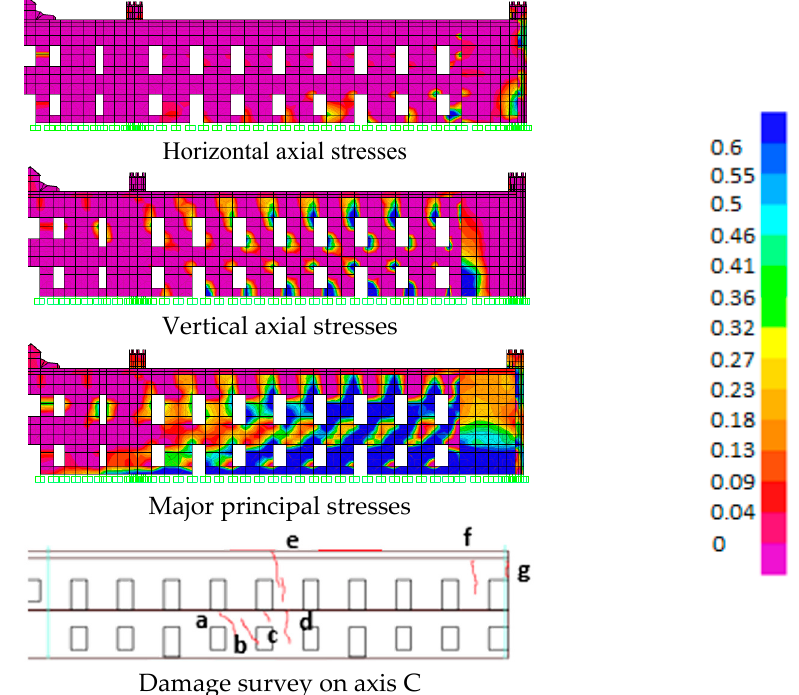
Figure 16. Comparison between rear stresses (MPa) and existing damage.